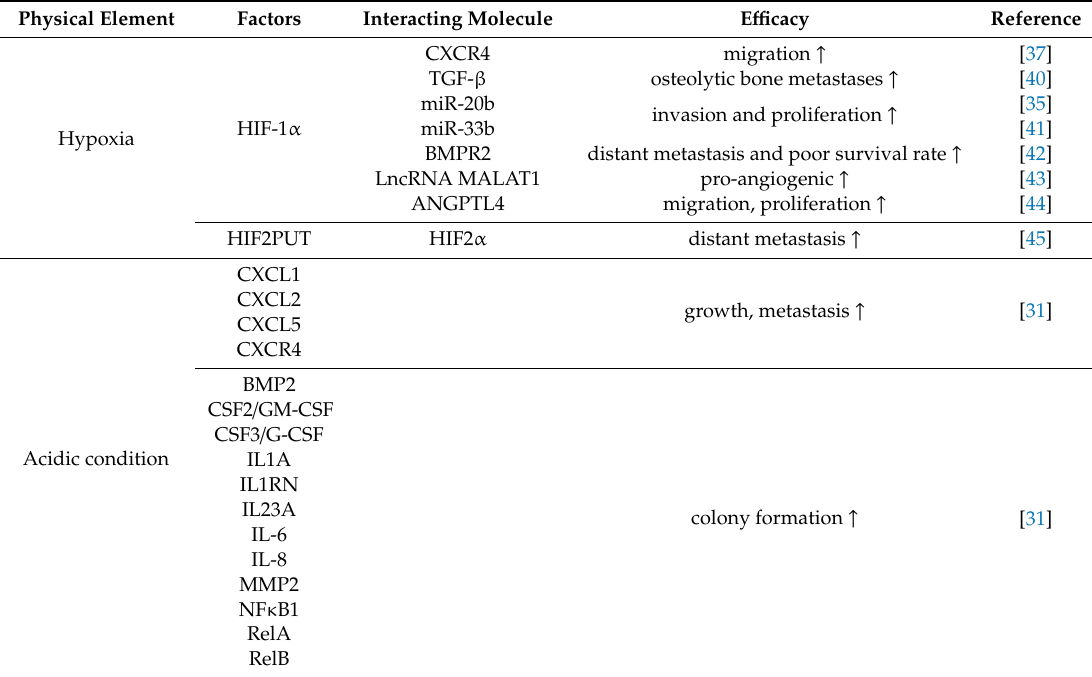
Table 2. The hypoxia and acidosis in the bone microenvironment a ff ect OS metastasis ( ↑ :